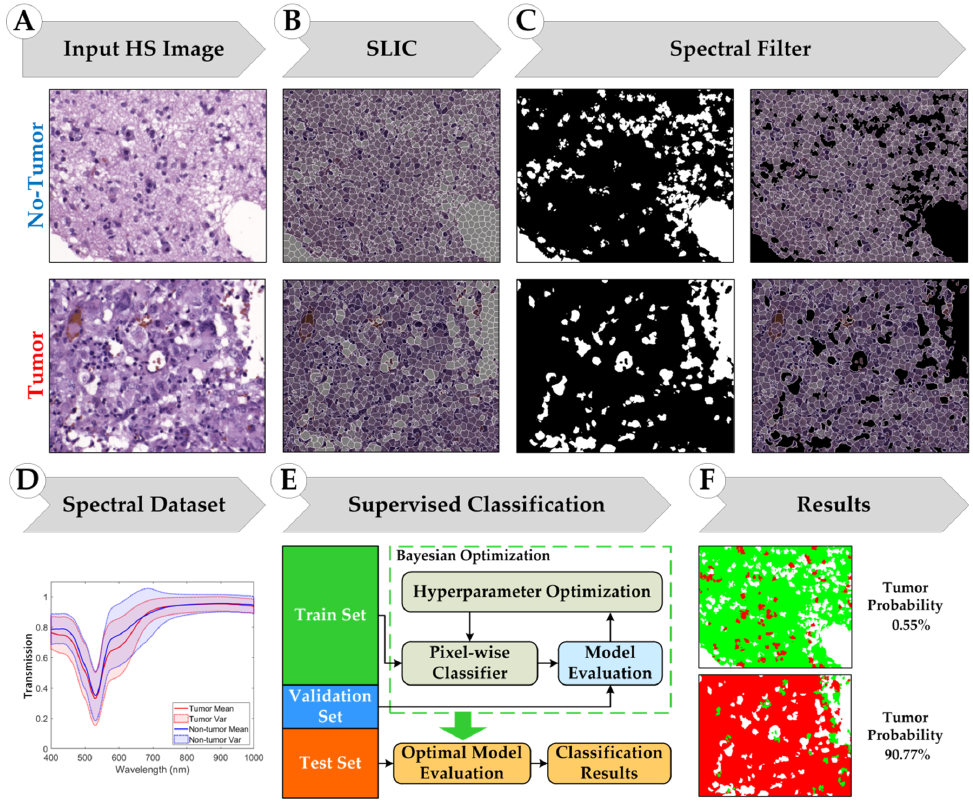
Figure 4. Proposed superpixel-based hyperspectral image processing